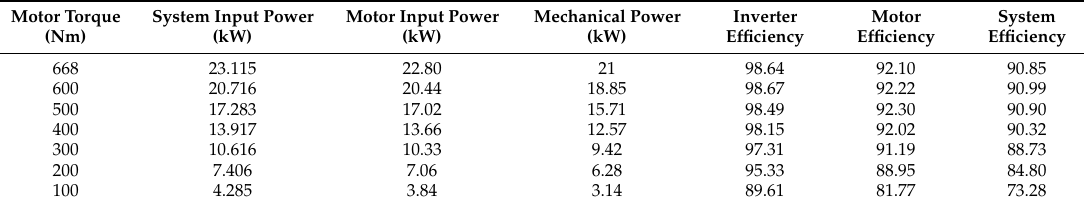
Table 11. Experimental results of the SiC-MOSFETs-based PMSM drive system in the rated speed by the system efficiency improvement